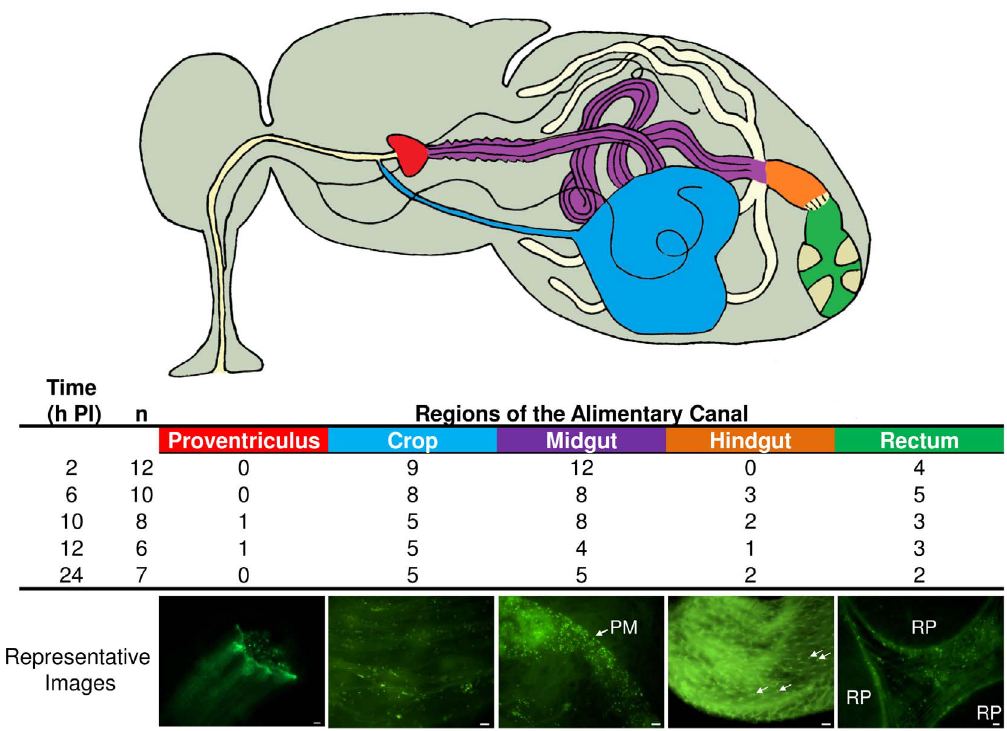
Figure 1. GFP- P.aeruginosa were found throughout the house fly alimentary canal up to 24 h post-ingestion (PI). House flies (n=20 in each of three replicates) were fed an average of 2.12 6 10 5 CFU (SD=8.36 6 10 4 ) bacteria. At 2, 6, 10, 12, and 24 h PI, flies (n=4 per replicate) were dissected to remove the entire gut, and the location and viability of GFP- P. aeruginosa was assessed by epifluorescent microscopy. The number (‘‘n’’) of house flies observed to have viable GFP- P. aeruginosa is indicated (of n=12 total flies observed/time point). Column headings of alimentary canal regions are color-coded to correspond to the same colors on the line drawing of the house fly anatomy, and the number of flies observed to have bacteria in those locations is indicated. Representative images of GFP- P. aeruginosa are shown, and bacteria are green rods and/or indicated by arrows. For more images, refer to Figure S1. PM, peritrophic matrix; RP, rectal pad. Scale bar=10 m m in all images. doi:10.1371/journal.pone.0079224.g001 Table 1 are an under-representation of both the amount of GFP- P.